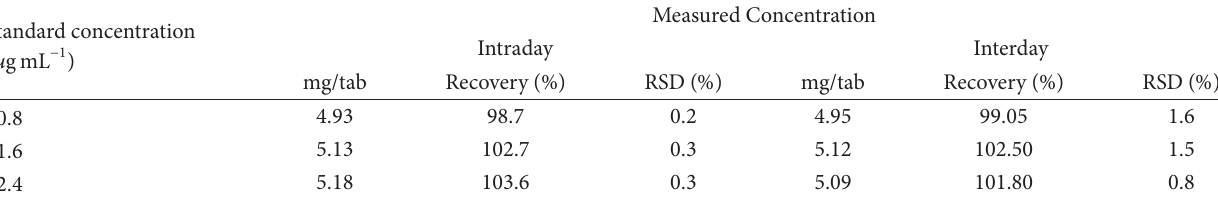
T 2: Intra- and interday assay precision data